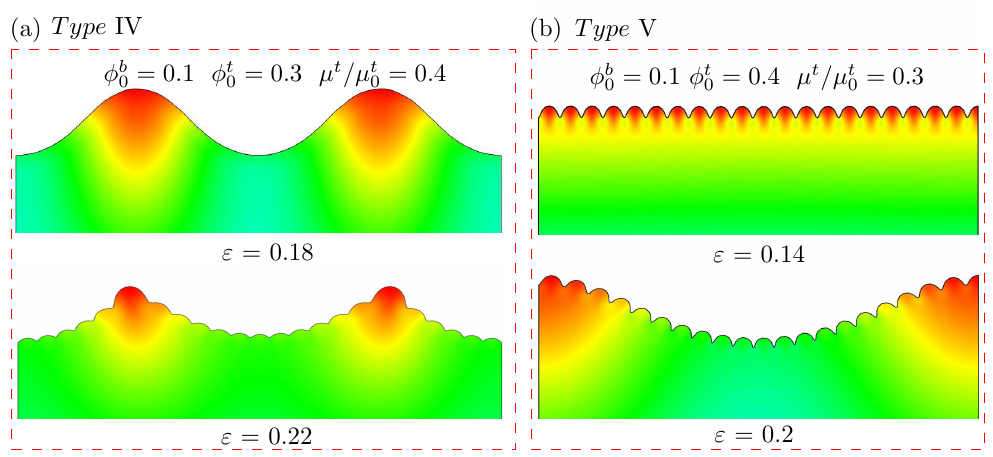
Figure 8. Surface morphologies of bilayer hydrogel modeled by the finite element (FE) simulations under different levels of compressive strain with the pre-absorption of water in the upper layer, when the initial volume fraction of polymer chain in the bottom layer was fixed as φ b volume fraction of polymer chain in the upper layer φ t These are typical surface instability patterns, named types IV and V, respectively.